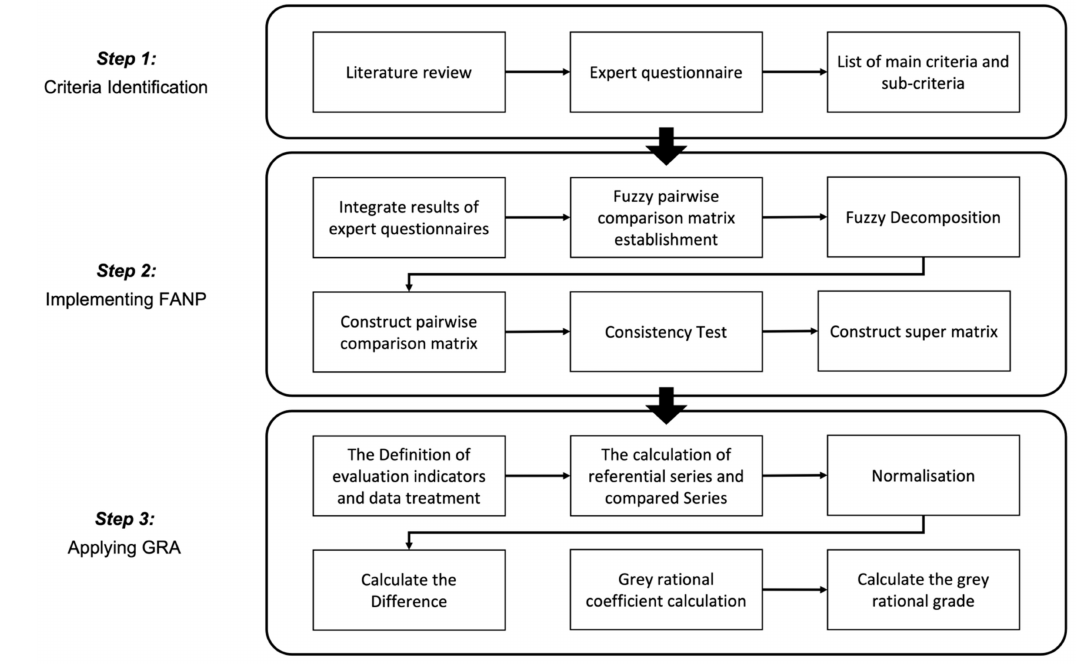
Figure 1. Research Processes.